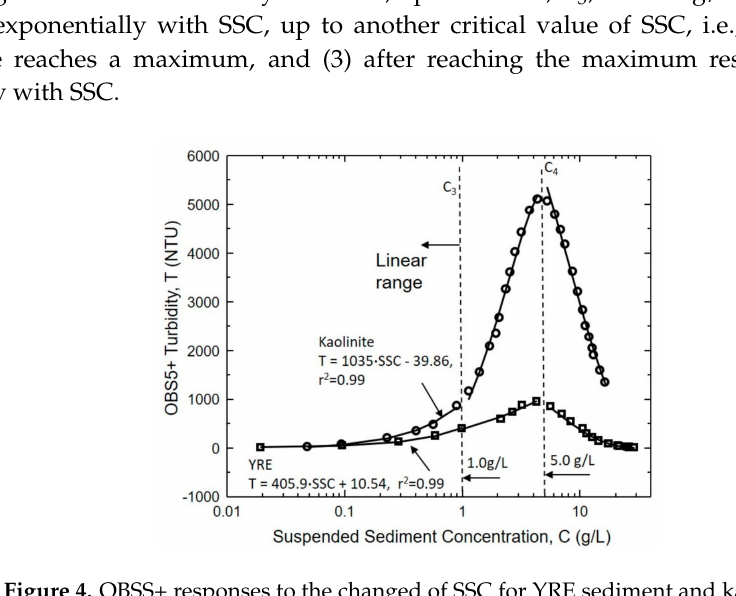
Figure 4. OBSS+ responses to the changed of SSC for YRE sediment and